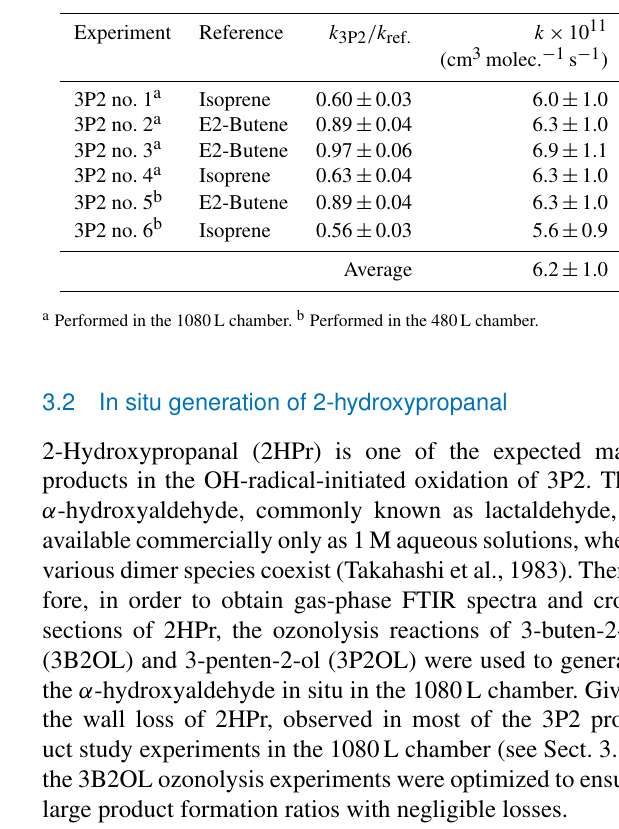
Table 1. Results of the 3P2 + OH kinetic